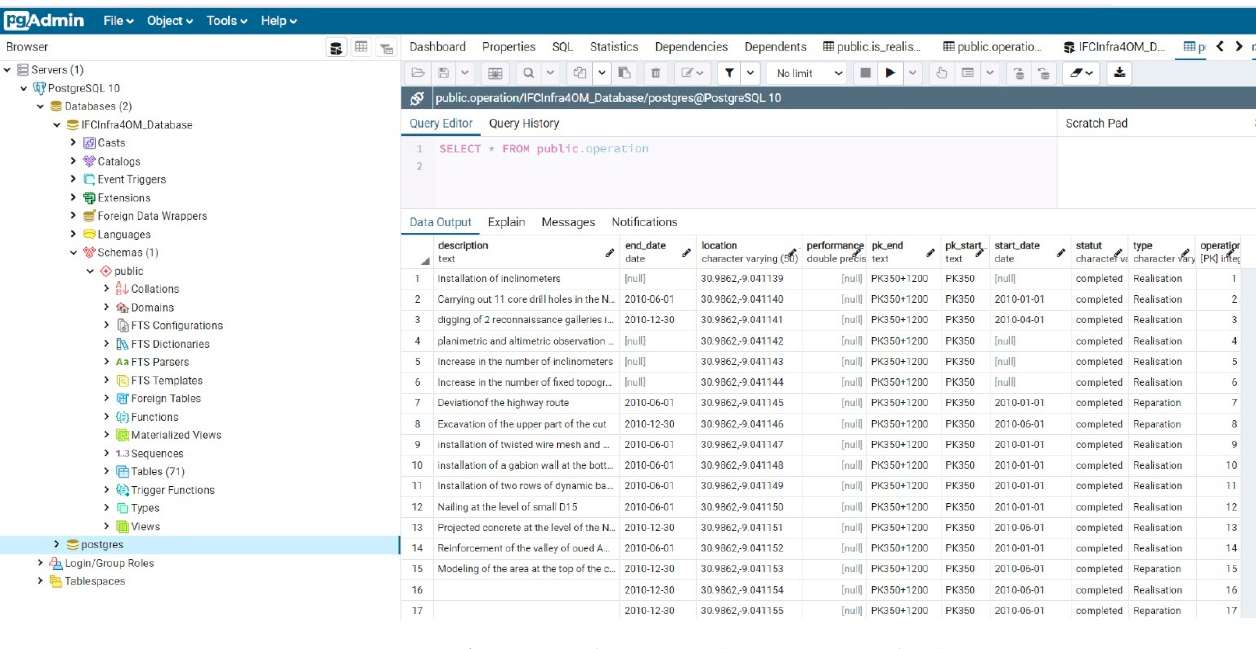
Figure 12. IFCInfra4OM Database Extract (PostgreSQL Database).